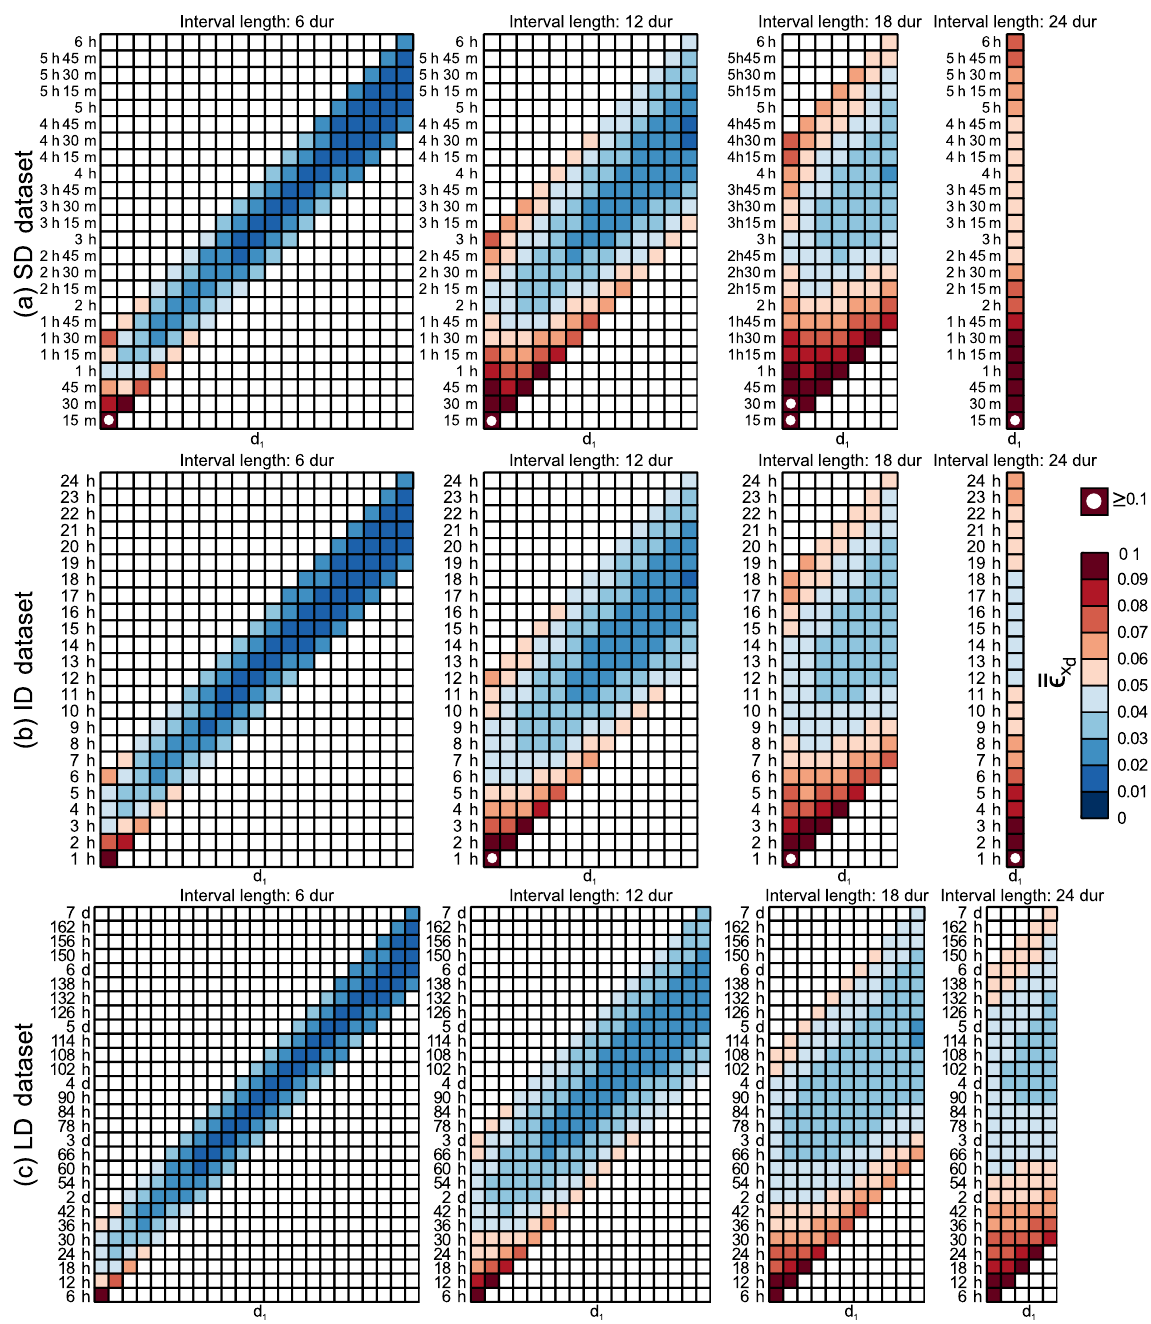
Figure 3. Cross-validation normalized RMSE averaged over all valid SS stations ( r x (horizontal axis) in the SD, ID, and LD datasets (panels a , b , and c , respectively). White circles indicate values between 0.15 and 0.3. See Fig. 1b and f for the identification of durations and scaling intervals within each